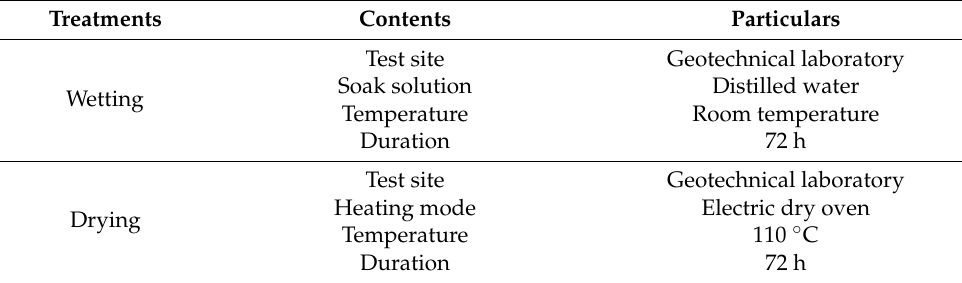
Table 1. Controlling parameters of cyclic wetting and drying test.